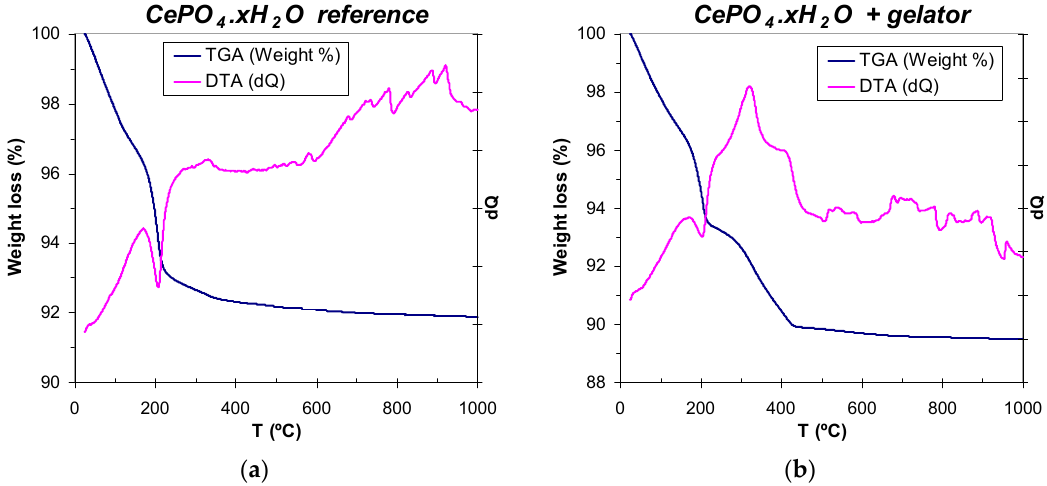
Figure 7. Differential thermal and thermogravimetric analysis (DTA-TGA) of as-prepared (60 °C-dried and washed) samples: ( a ) non-templated reference CePO 4 ; and ( b ) templated CePO 4 xerogel.